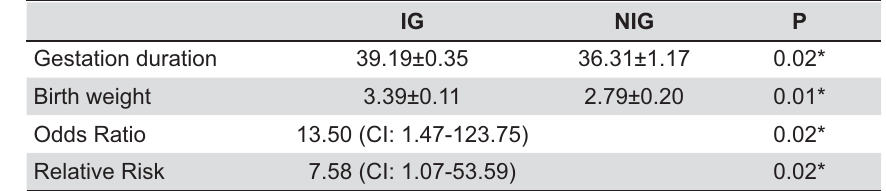
Table 3- (cid:19)j(cid:12){Y(cid:17)(cid:12)(cid:25)(cid:17)(cid:19)&(cid:26)(cid:19)(cid:13)(cid:17)(cid:16)(cid:15)&(cid:18)&(cid:12)(cid:20)(cid:14)V(cid:19)(cid:20)(cid:16)(cid:17)(cid:14)(cid:20)?(cid:17)(cid:12)(cid:20)(cid:19)&(cid:12)(cid:19)(cid:23)(cid:17)(cid:21)(cid:20)(cid:14)(cid:20)(cid:15)&(cid:12)(cid:19)(cid:18)Y(cid:16)(cid:14)(cid:20)(cid:15)&(cid:12)(cid:19)(cid:14)(cid:12)(cid:18)(cid:19)’(cid:15)(cid:16)(cid:20)(cid:31)(cid:19)\(cid:17)(cid:15)(cid:23)(cid:31)(cid:20)(cid:19)(cid:14)(cid:20)(cid:19)j|(cid:19)=(cid:15)(cid:12)(cid:20)(cid:17)(cid:16)}(cid:17)(cid:12)(cid:20)(cid:15)&(cid:12)J(cid:19)(cid:14)(cid:12)(cid:18)(cid:19)~j|(cid:19)=(cid:12)&(cid:19)(cid:15)(cid:12)(cid:20)(cid:17)(cid:16)}(cid:17)(cid:12)(cid:20)(cid:15)&(cid:12)J